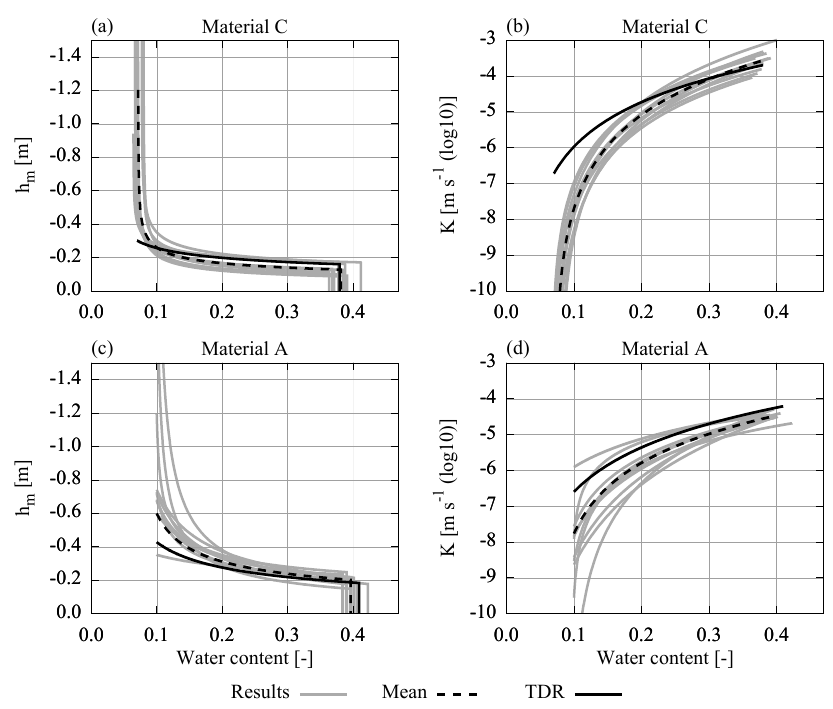
Figure 15. The resulting material parameters estimated from measured data are shown for the 10 best ensemble members (Sect. 3.1.2) together with the mean of these parameter sets (Table 3) and a reference parameter set determined from TDR data acquired during the same experiment (Jaumann and Roth, 2017). The deviation from the reference parameters can be explained with representation errors in the GPR analysis (e.g., neglecting compaction interfaces) and missing data (e.g., for low water contents in material A). The plot range of the parameters is adjusted to the water content range of the corresponding